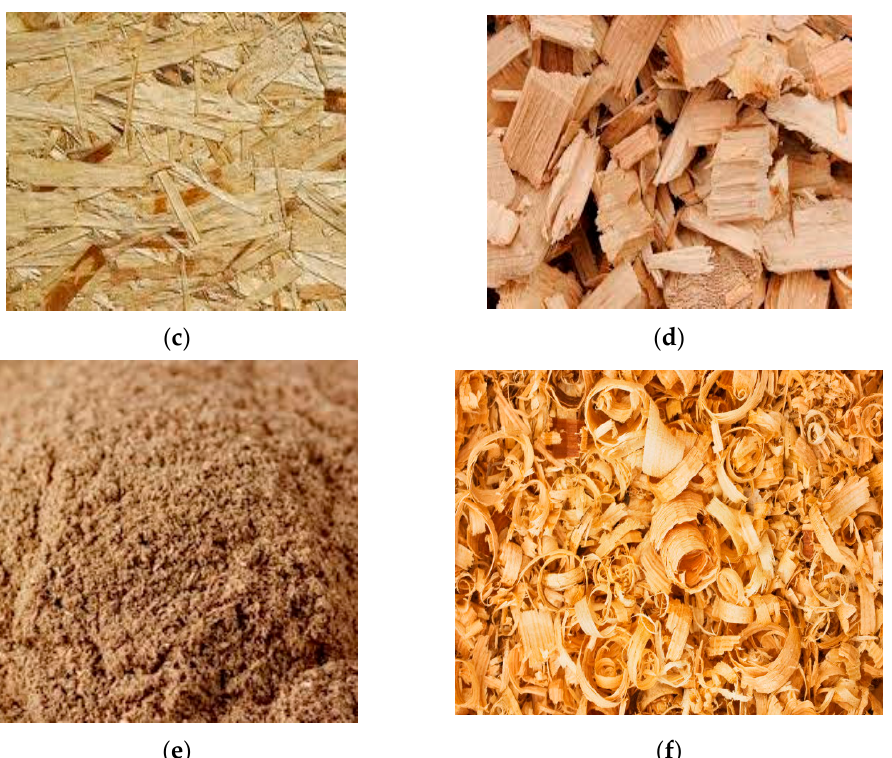
Figure 1. Basic wood elements for wood composites [18], ( a ) Logs, ( b ) Wood fiber, ( c ) Wood Flakes, ( d ) Wood chips, ( e ) Wood powder, ( f ) Wood swiths.